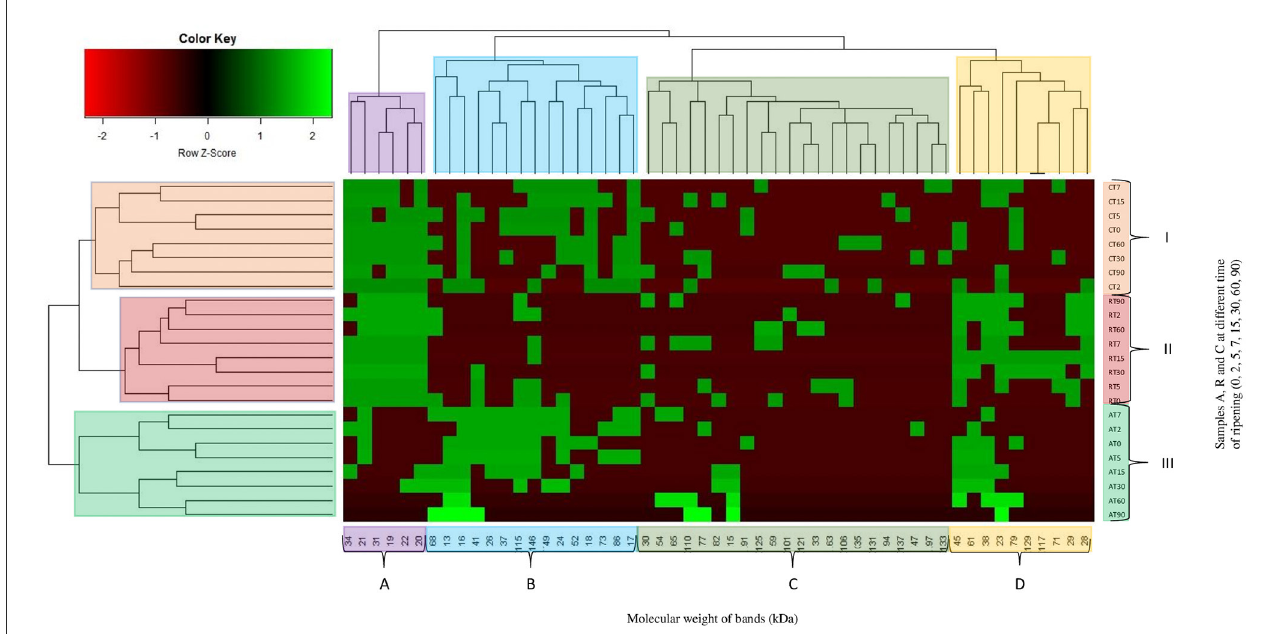
FIGURE8 Hierarchical clustering analysis and heatmap visualization of SDS fingerprint (bands and their molecular weight [kDa]) and samples (non-inoculated sausages, C; sausages inoculated with Lcb. casei N87 cultivated under anaerobiosis A; sausages inoculated with Lcb. casei N87 cultivated under respiratory conditions R) during ripening (T0, T2, T5, T7, T15, T30, T60, and T90). Colors are used to identify the different